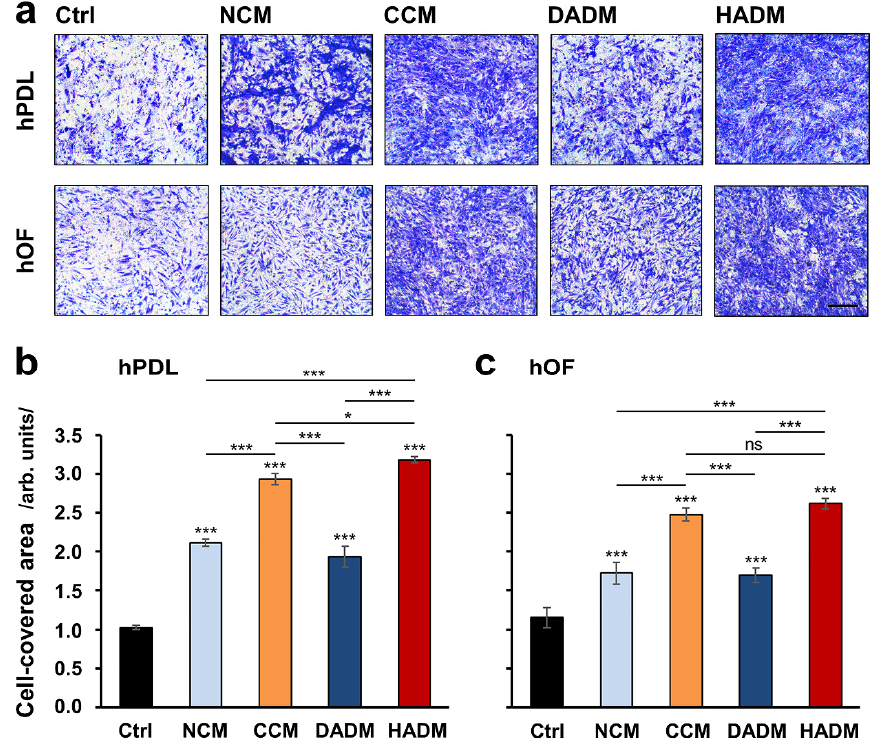
Figure 1. Pro-migratory effects of four porcine-derived collagen matrices on primary human oral cell types. Migration of human periodontal ligament (hPDL) ( a , b ) and human oral fibroblasts (hOF) ( a , c ) cells toward non-crosslinked collagen matrix (NCM), crosslinked collagen matrix (CCM), dried acellular dermal matrix (DADM), and hydrated acellular dermal matrix (HADM) matrices was evaluated by transwell migration assay using filters with 8 µm pore size. ( a ) Representative images of fixed and stained cells that have migrated to the lower side of the filter in each of the experimental groups. Scale bar, 500 µm. ( b , c ) Bar charts presenting quantification of cell migration in the absence (Ctrl) or presence of collagen matrices by measuring the area on the lower side of the filter covered with migrated cells. Data represent means ±SD from three independent experiments performed with three different cell donors, in duplicates. Significant differences to the respective control unless otherwise indicated, *** p < 0.001, * p < 0.05, ns: not